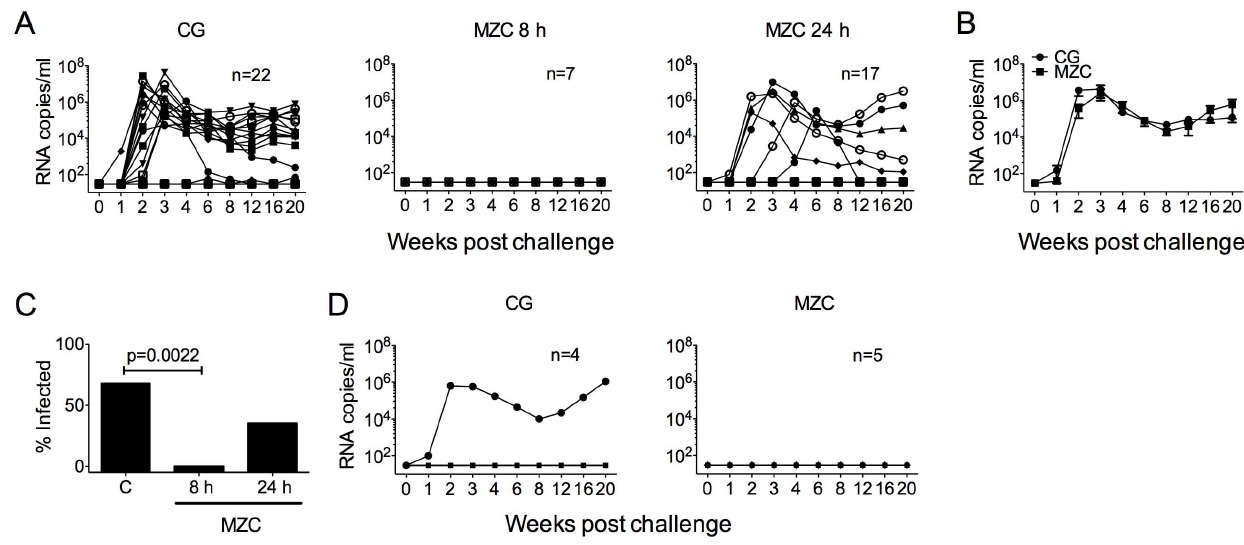
Figure 4. MZC completely protects against SHIV-RT infection vaginally for up to 8 h and rectally for 1 h. A) MZC or CG was administrated vaginally daily for 2 wks followed by vaginal challenge 8 or 24 h after the last gel application. The number of animals in each treatment group is indicated. For CG, this includes 8 real time and 14 historical controls. Plasma viral loads for each animal are shown over time. B) Mean ( 6 SEM) plasma viral load of infected animals from each group in (A). C) The percent infection in each of the different treatment groups. D) MZC or CG was administrated once rectally followed by rectal challenge 1 h later. Plasma viral loads are shown for each animal over time. The number of animals in each treatment group is